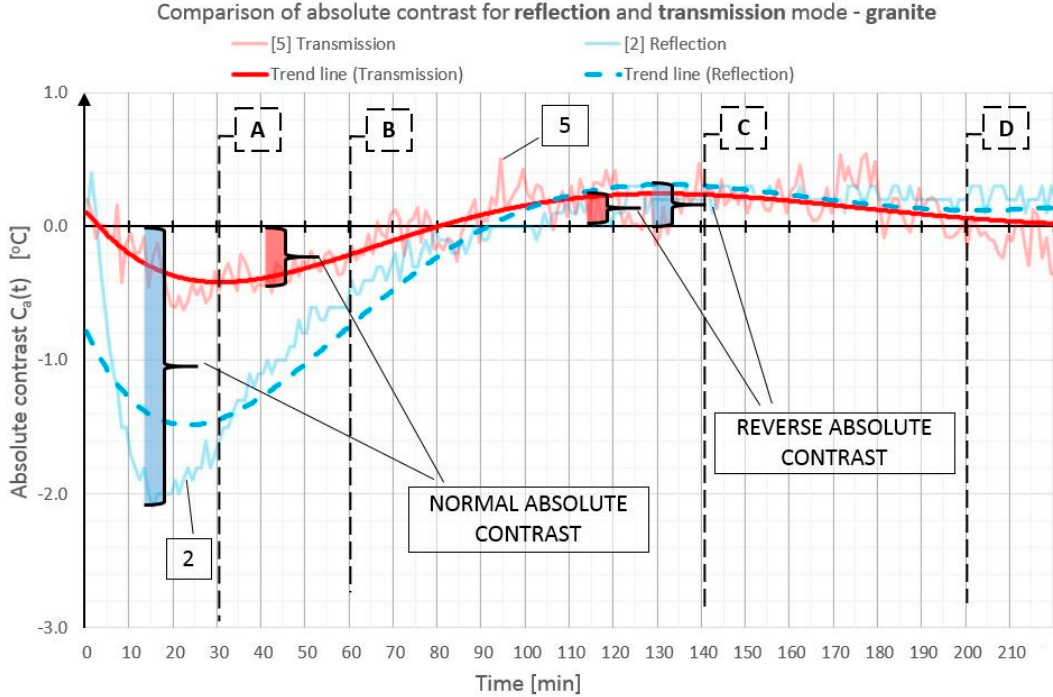
Figure 14. Diagram of absolute contrast in a reflection mode and in a transmission mode for granite inclusion, with marked places where normal absolute contrast and inverse absolute contrast occur (heating from a distance of 1.5 m).